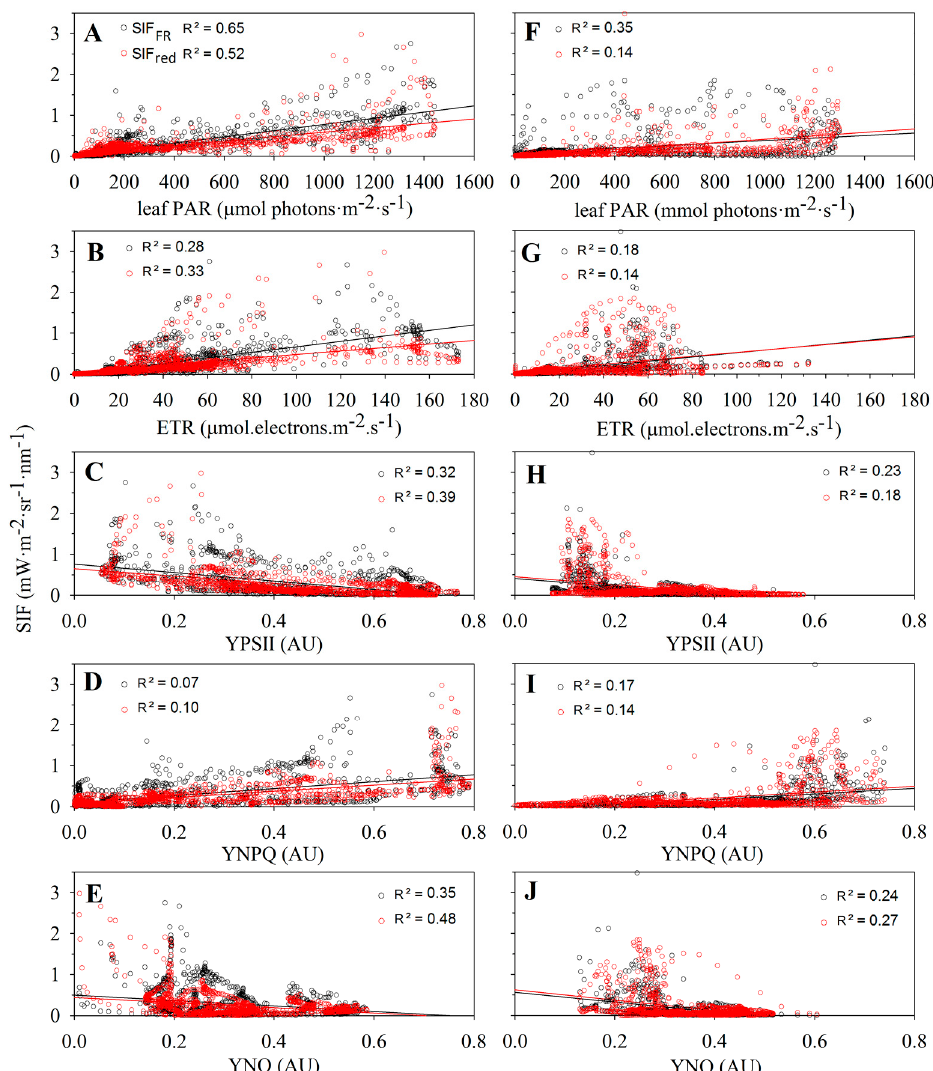
Figure 3. Scatterplots of leaf measurements of SIF red (red) and SIF FR (black) against LIFT measured photosynthetic parameters and leaf PAR from leaves of both avocado ( A – E ) and orange jasmine ( F – J ). LIFT and SIF measurements were collected simultaneously from sunrise to sunset with a three-minute time resolution. Plots show data from all time points and measurement days, where each point represents the mean of six leaf replicates collected at the same time on a single measurement day ± 3 min. The black and red lines show the linear fit for SIF red (red) and SIF FR (black).